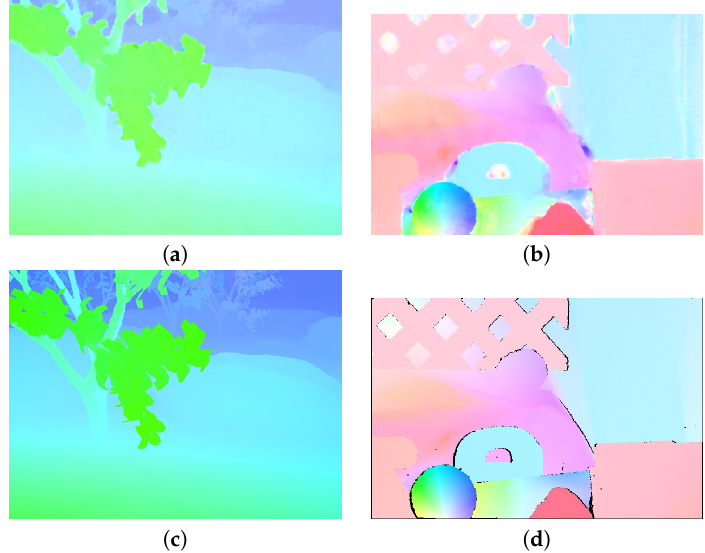
Figure 11. Color-coded optical flow. ( a ) Color-coded optical flow for Grove2. ( b ) Color-coded optical flow for RubberWhale. ( c ) Ground truth for the Grove2 sequence. ( d ) Ground truth for the RubberWhale